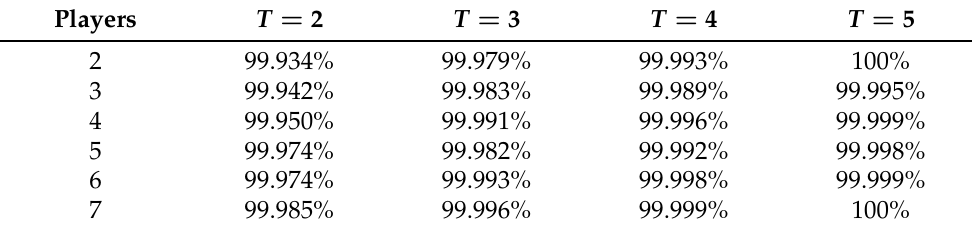
Table 10. Percentage of instances fulfilling the condition of Theorem 2 for the first set of